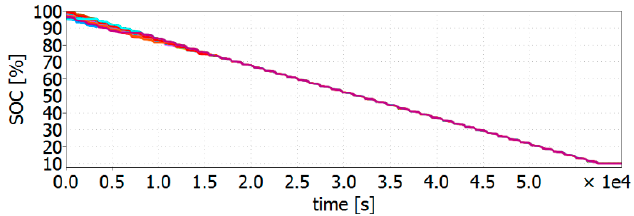
Figure 9. SOC of the proposed smart battery pack (SBP) with a variation of 5% on the initial SOCs.